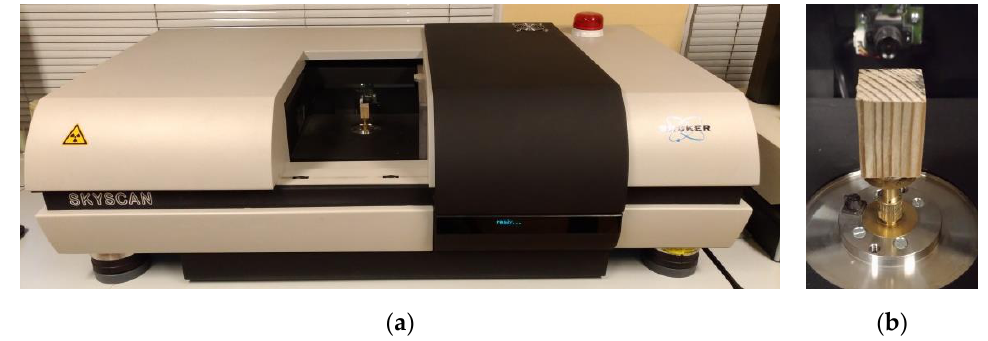
Figure 4. ( a ) Bruker SkyScan 1172 device; ( b ) sample of timber mounted on stage inside scanning chamber.